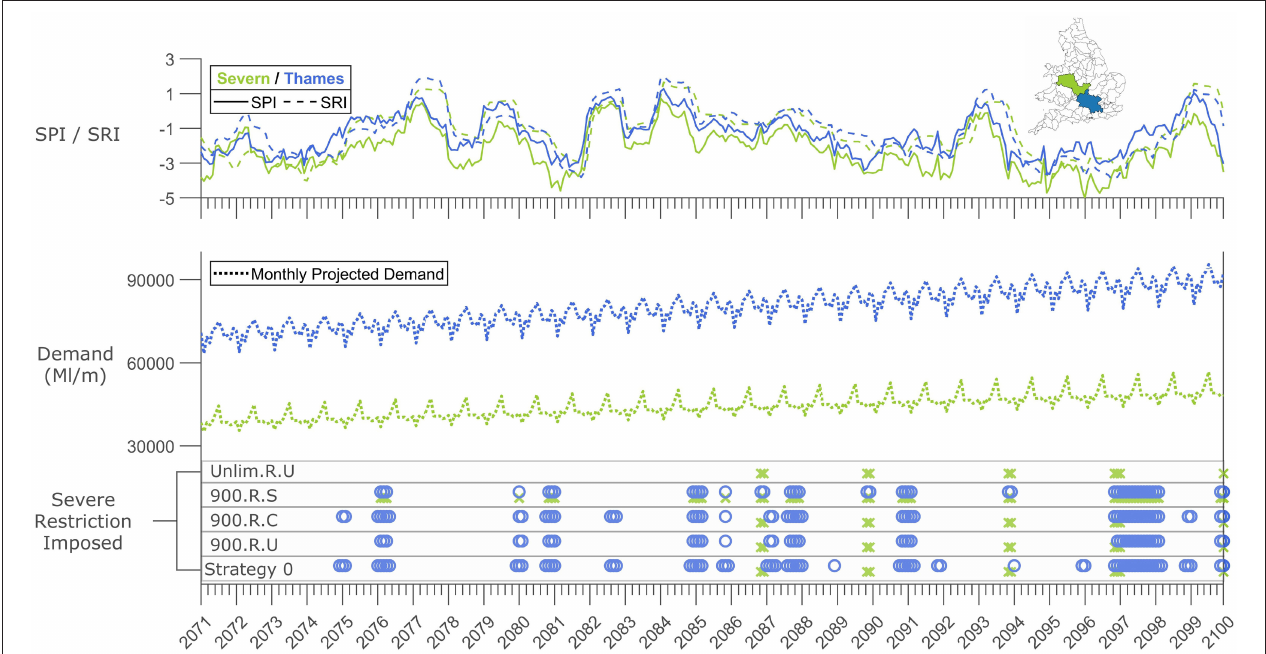
FIGURE 9 | Time series of SPI, SRI, projected water demand, and severe restrictions for the Severn (green) and Thames (blue) study areas when simulated under one Far Future scenario with Strategies 0, 900.R.U, 900.R.C, 900.R.S, and Unlim.R.U. Each marker represents a severe restriction imposed to Severn Trent ( × ) or Thames Water ( ◦ )